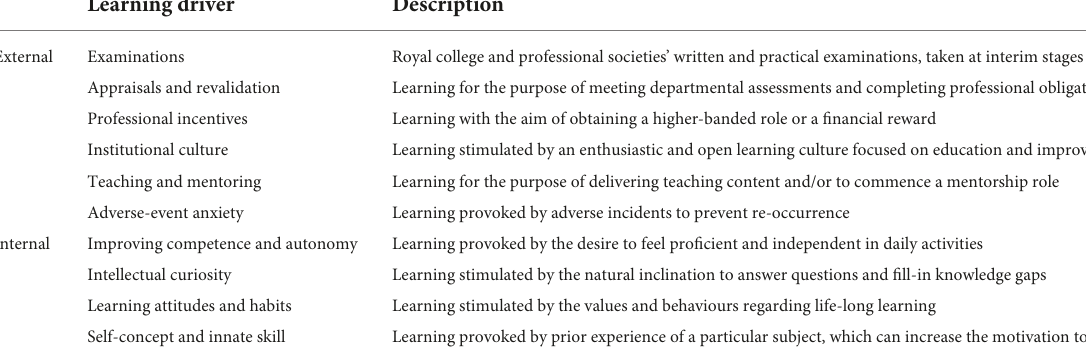
TABLE 1 Internal and external motivations for individual